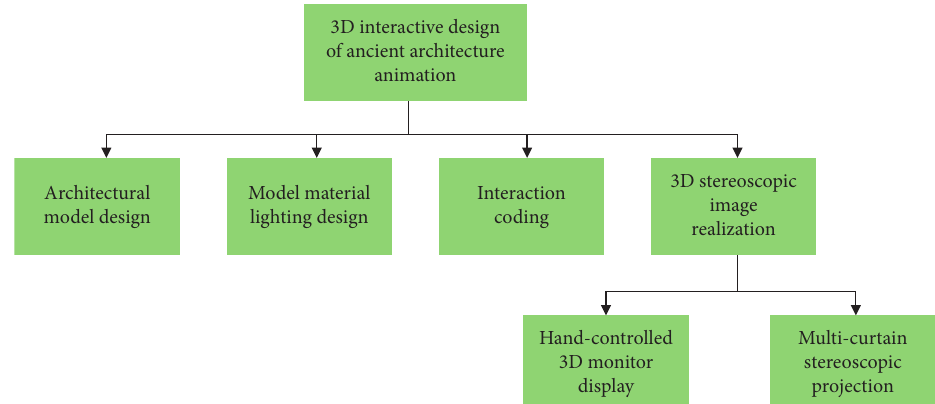
Figure 4: Procedures of system design and development.